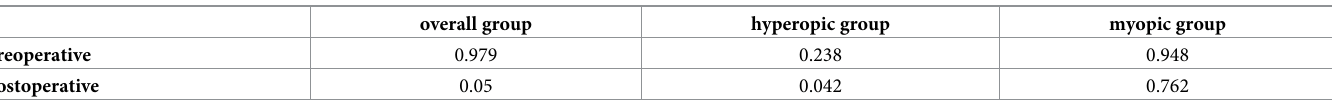
Table 1. Correlation between angle κ and CDVA in all three groups, pre- and postoperatively